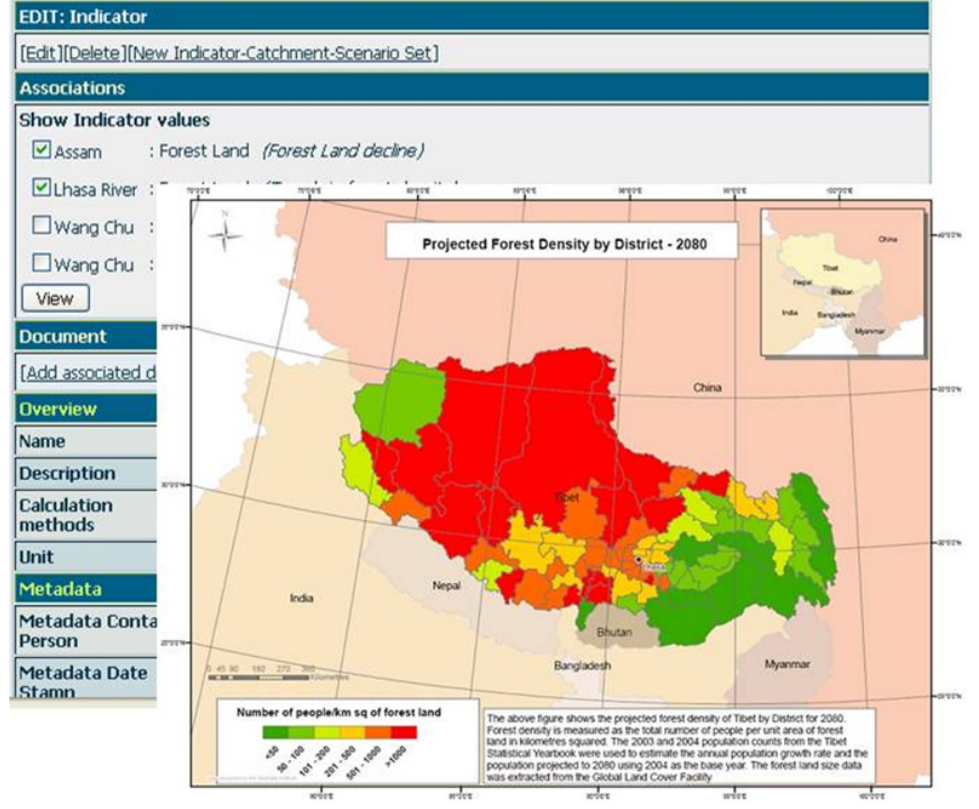
Figure 6. IWRMS components RBISscen and RBISind for indicator